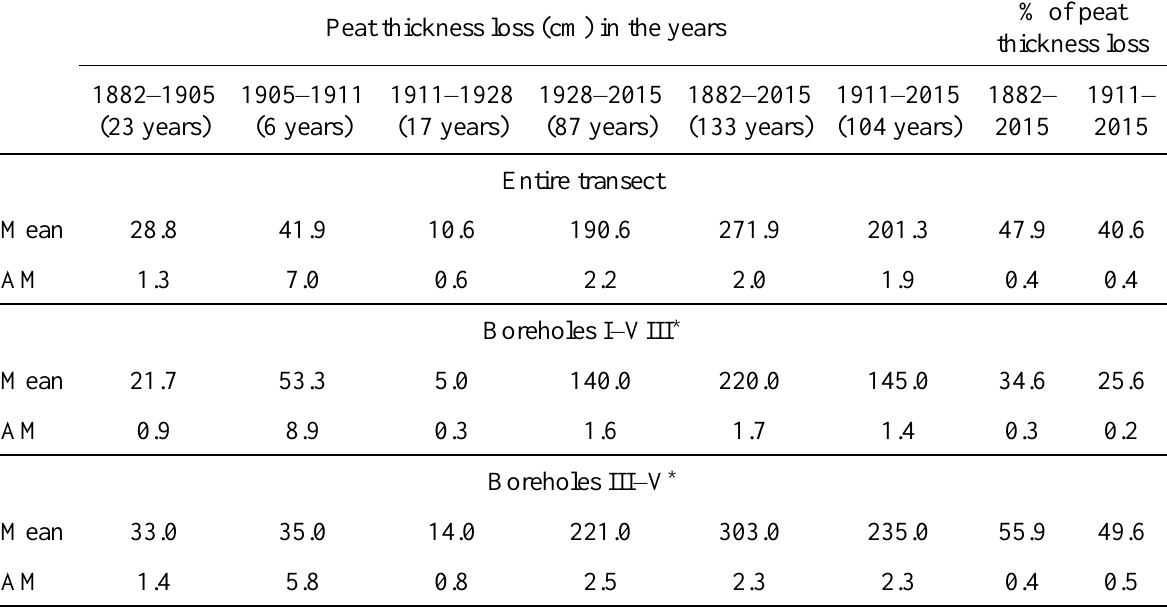
Table 2. Peat thickness loss in the investigated time along the A–B transect in Dublany